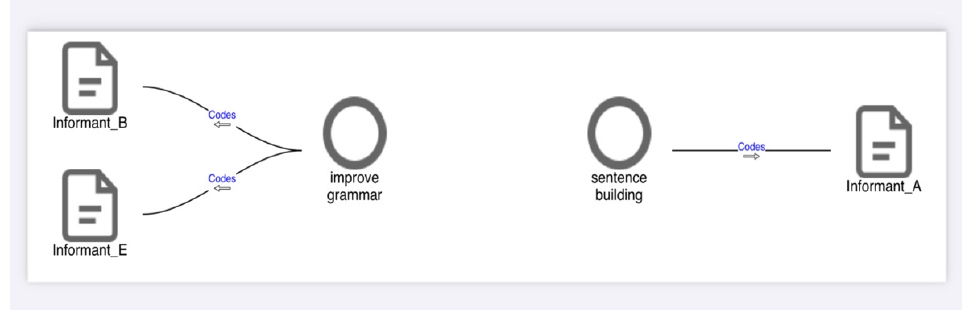
Figure 3. The effectiveness of Headgram .